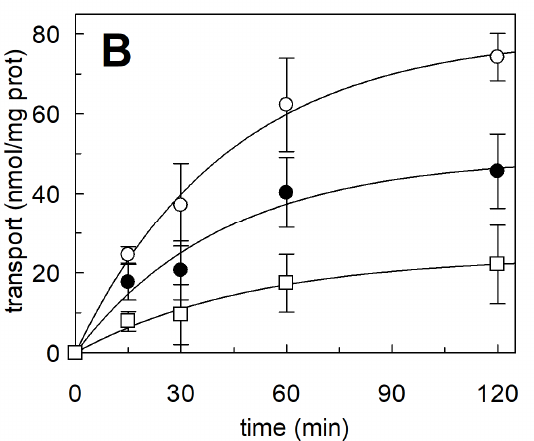
Figure 3. Specificity of unidirectional transport rection mediated by ASCT2 WT and C467A mutant in proteoliposomes. In ( A ), the effect of externally added amino acids on the [ 3 H]-glutamine unidirectional transport by ASCT2 WT and C467A mutant is shown. Purified WT (light grey) and C467A (dark grey) proteins were reconstituted in proteoliposomes, as described in Materials and Methods. The transport was started by adding 500 µM [ 3 H]-glutamine and 50 mM Na-gluconate in the presence of 10 mM indicated amino acids. The transport was stopped after 60 min according to the stop inhibitors method. The transport activity was calculated as percent of residual activity with respect to condition without cholesterol. ** Significantly different from the control sample as estimated by Student’s t -test ( p < 0.01). The absolute values of the control conditions (without externally added amino acids) are: 15.6 ± 3.9 nmol/mg prot/30 min and 43.8 ± 7.15 nmol/mg prot/30 min, for WT and C467A, respectively. In ( B ), time course analysis of [ 3 H]-glutamine and [ 3 H]-serine unidirectional transport. The proteoliposomes were reconstituted with WT (□) or C467A mutant ( , → ), as described in Materials and Methods. The transport was started by adding 500 µM [ 3 H]-glutamine ( ) or [ 3 H]-serine (□, → ) and 50 mM Na-gluconate to proteoliposomes. The transport was stopped at indicated times according to the stop inhibitor method. In ( A , B ), results are means ± SD from three independent experiments.